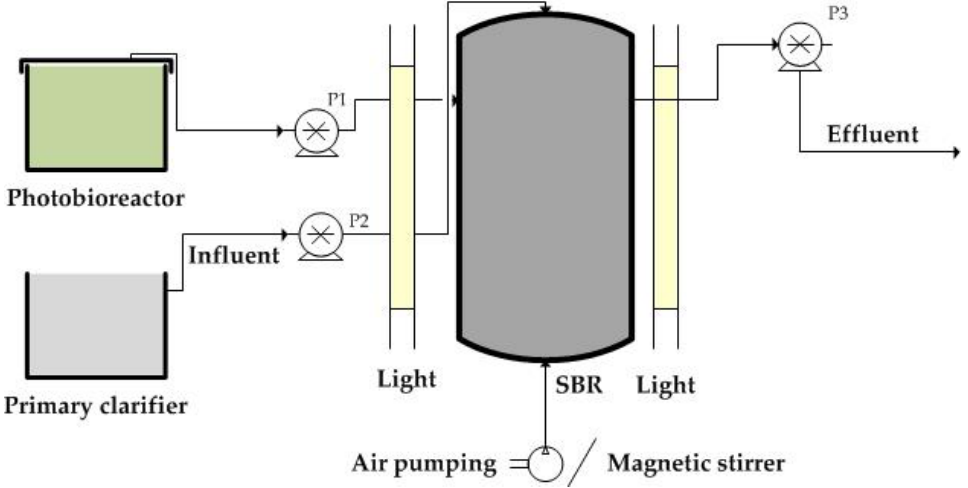
Figure 1. Schematic illustration of an integrated process treatment photobioreactor. (P1, P2, P3; pump).